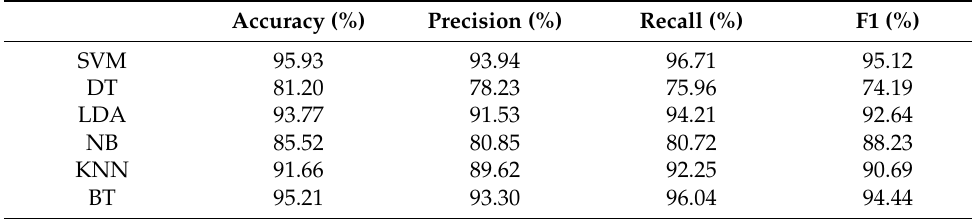
Table 5. Experimental results of the PAMAP2 data set using different classifiers. Accuracy (%)